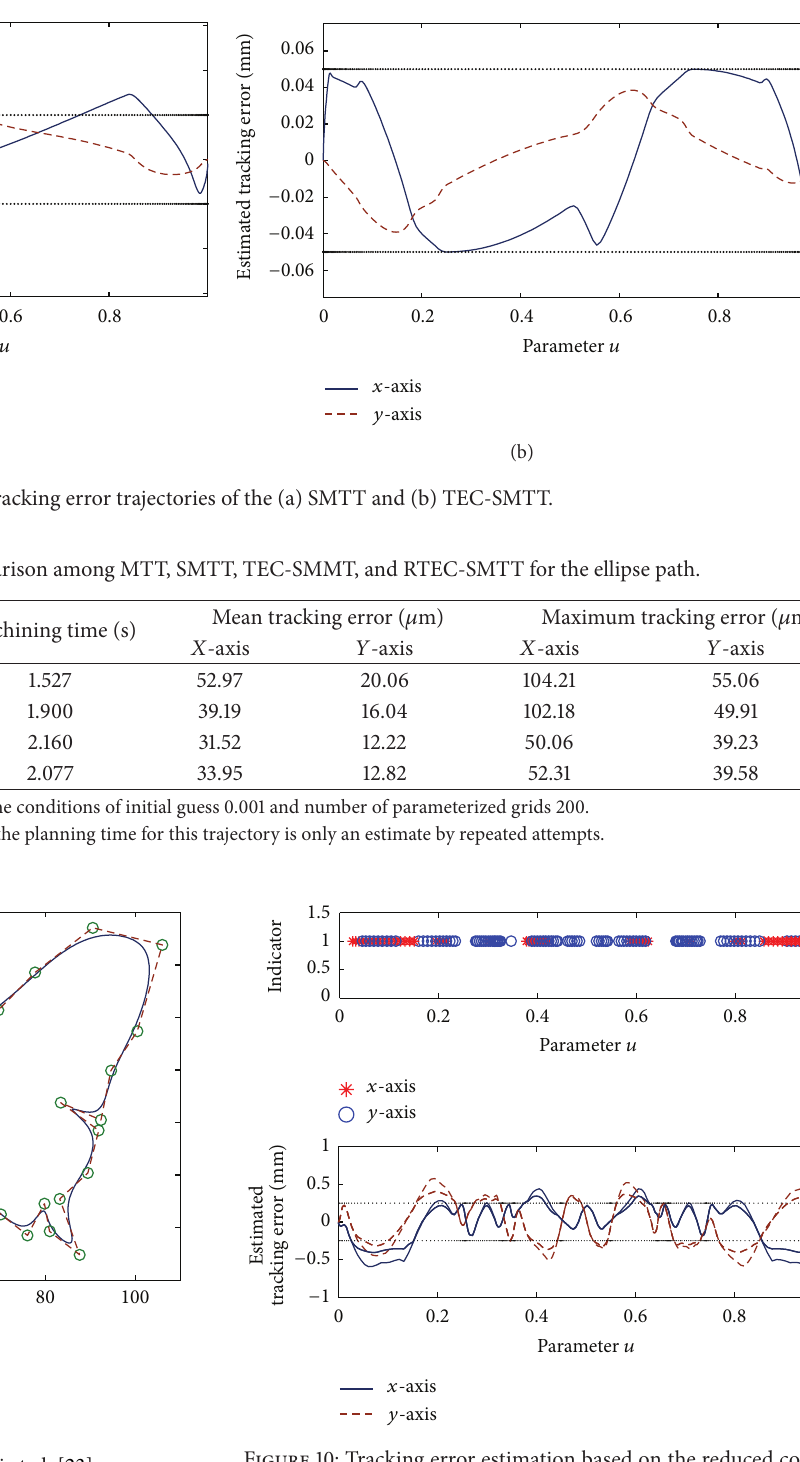
Figure 9: A butterfly contour Tsai et al. [23]. Figure 10: Tracking error estimation based on the reduced control system model and the corresponding active constraints indicator.